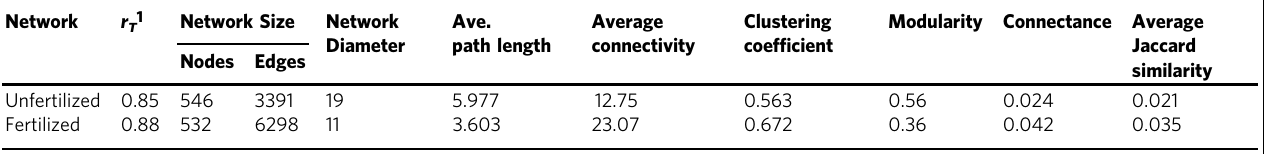
Table 1 Topological properties of microbial co-association networks in unfertilized and fertilized soils.